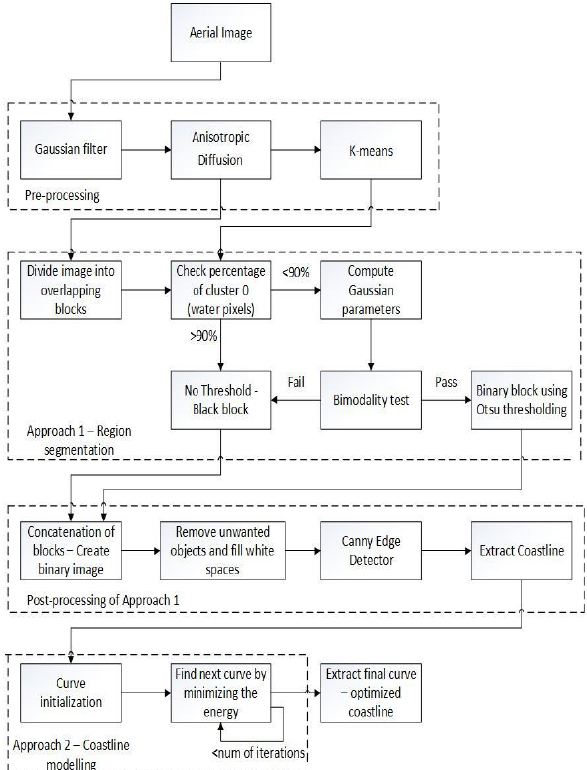
Figure 1. Block Diagram of the proposed methodology